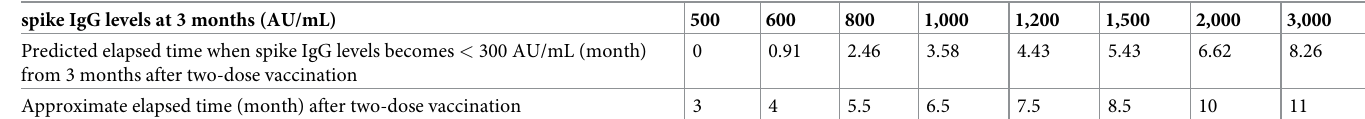
Using equations, we made a nomogram showing minimum spike IgG levels at 3 months in order to maintain certain levels of spike IgG at 6 and 8 months (Table 4). Table 5 is another nomogram showing the month at which we expect to reach the cut-off level of spike IgG (300 AU/mL) after two-dose vaccination. For example, if spike IgG at 3 months was 800 AU/mL, expected elapsed time to reach spike IgG level < 300 AU/mL would be 5.5 months.